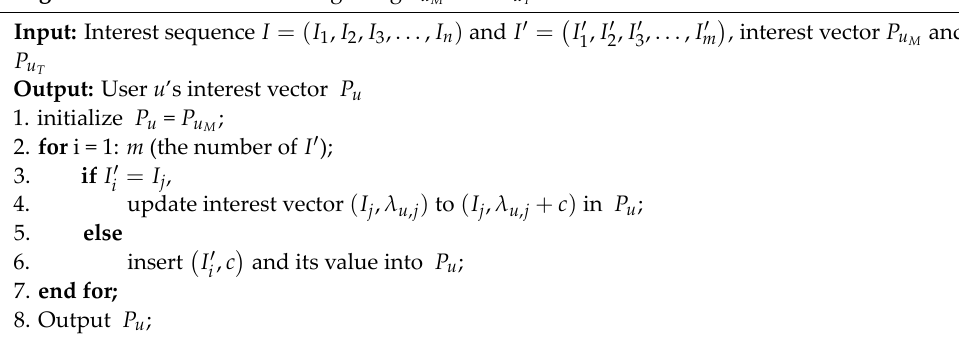
Algorithm 1. Procedure for integrating P u